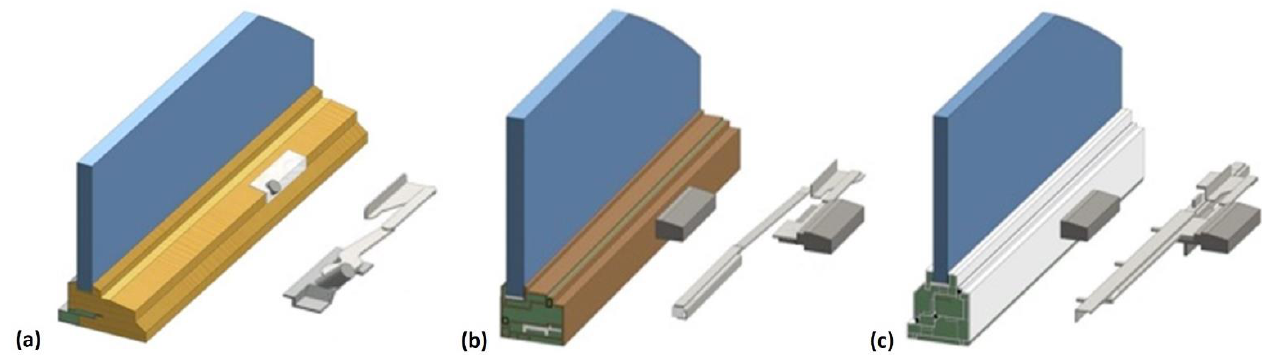
Figure 1. Simplified geometries of wooden ( a ), fiberglass ( b ), and PVC ( c ) frames and the associated operating hardware designs examined in preliminary research [31].